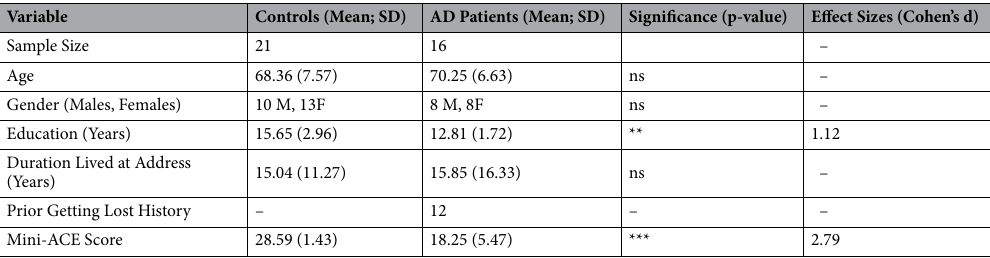
Table 1. Participant Demographics. **p < 0.01, ***p < 0.001, ns = not